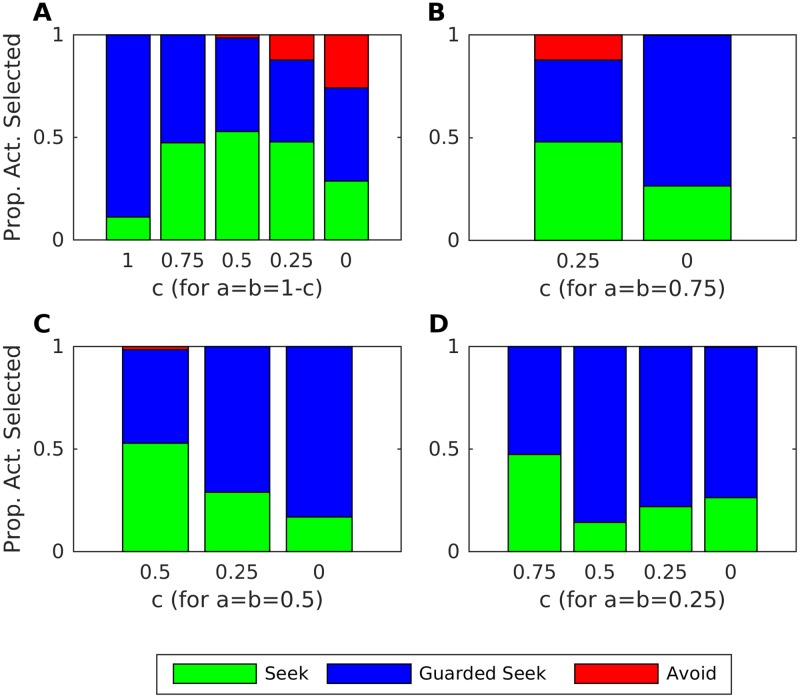
Ambivalent attachment for combinations of misleading and ambiguous exteroceptive cues.Mean (over repetitions) proportion of actions chosen by the infant during the last 10 iterations, when they were paired with an inconsistent caregiver (q = 0.4) exhibiting varying rates and types of affective communication errors. A: Proportions for a = b = 1-c and c decreasing from 1 to 0. B: Proportions for a = b = 0.75 with c decreasing from 0.25 to 0. C: Proportions for a = b = 0.5 and c decreasing from 0.5 to 0. D: Proportions for a = b = 0.25 and c decreasing from 0.75 to 0.